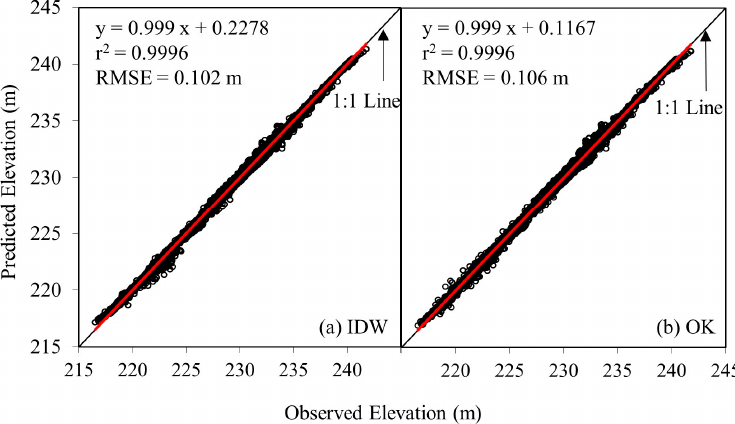
Figure 5. Comparison of the observed and predicted elevation values using both ( a ) IDW and ( b ) OK methods in selected 24 sections.